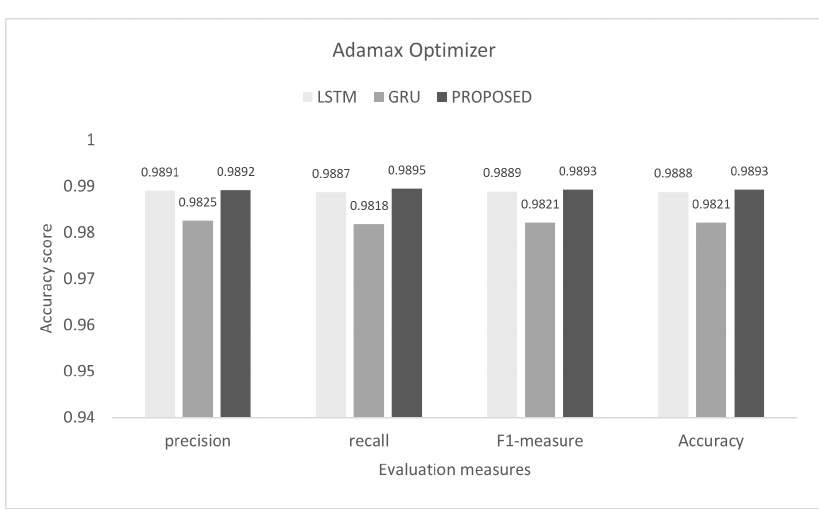
Figure 8. Evaluation on Nadam with the combined DDoS dataset.